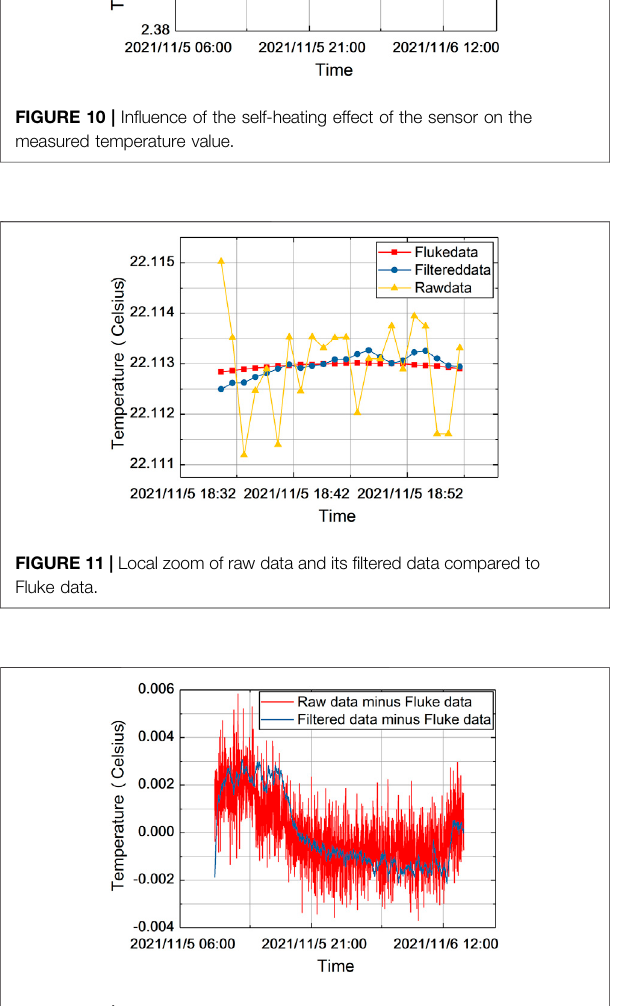
FIGURE 12 | Comparison of data deviation before and after fi ltering.